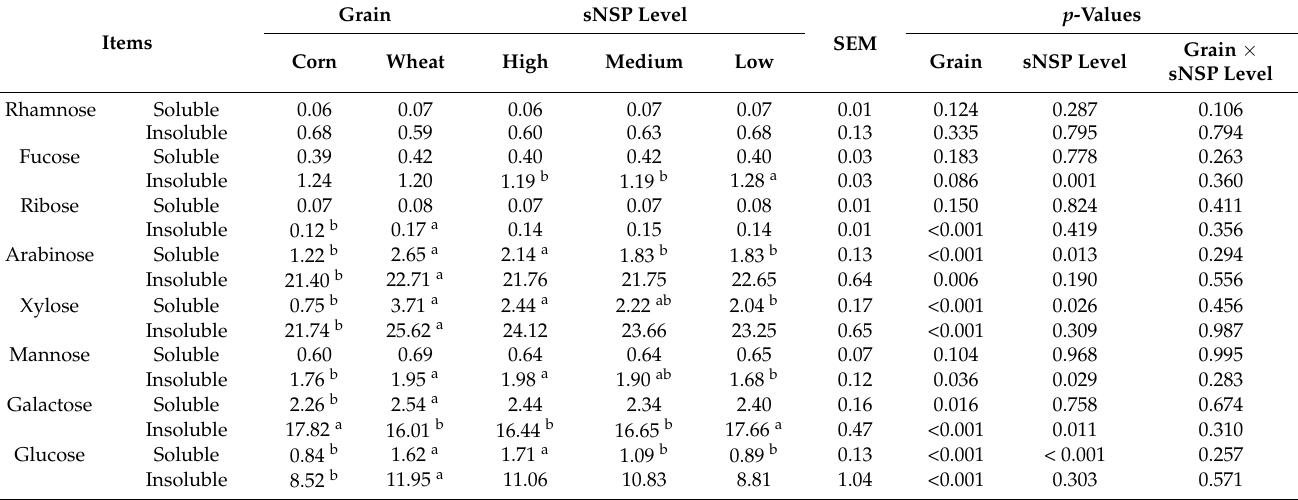
Table 10. Effect of dietary soluble NSP (sNSP) level and grain source on apparent total tract flow